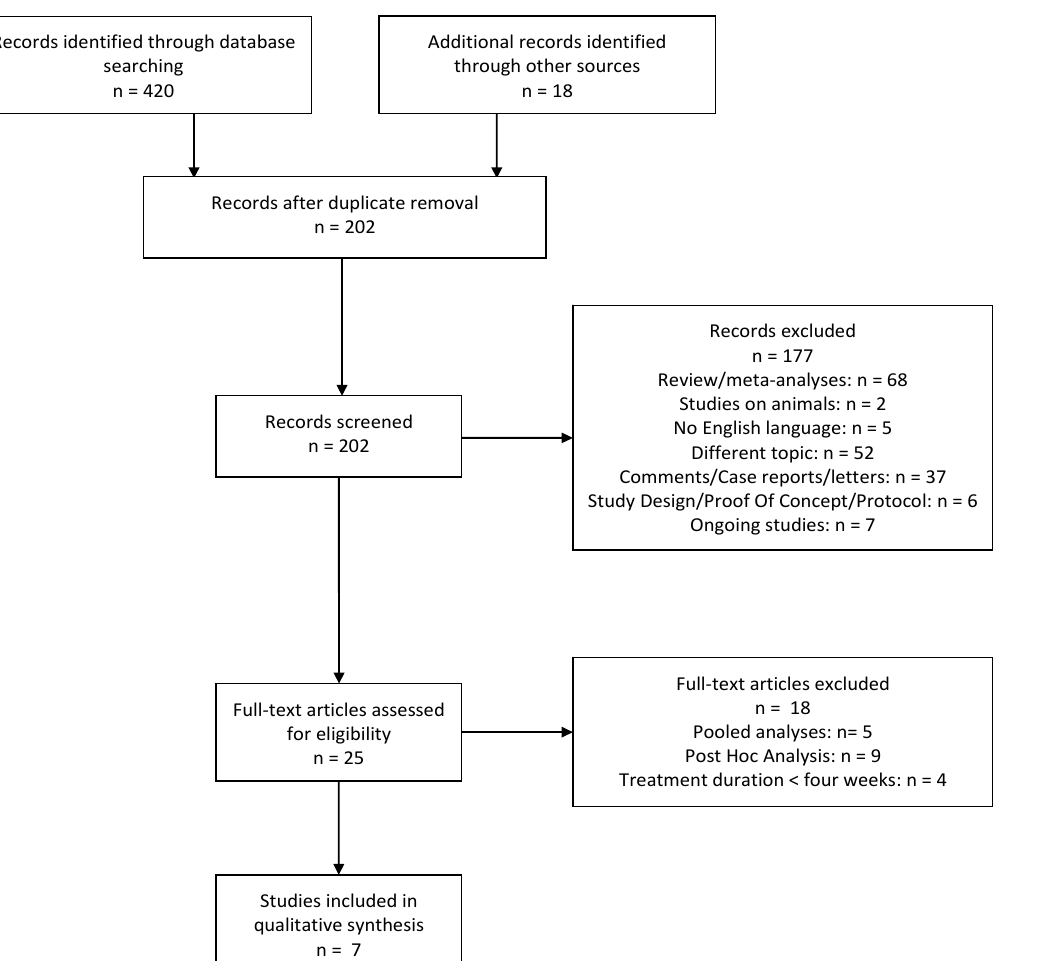
Figure 1. PRISMA flowchart for systematic reviews.